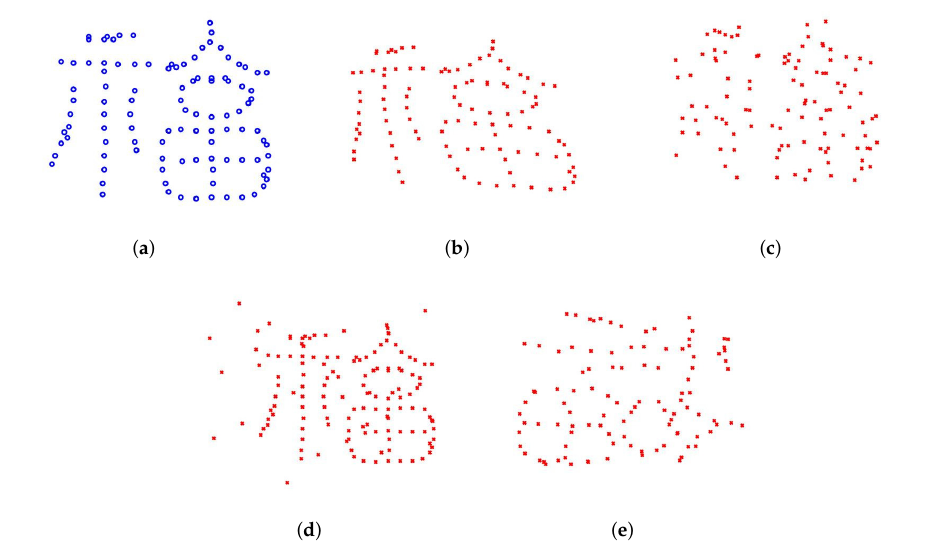
Figure 3. ( a ) shows model blessing point sets, and ( b – e ) show point sets added with deformation, noise, outliers, and rotation, respectively.